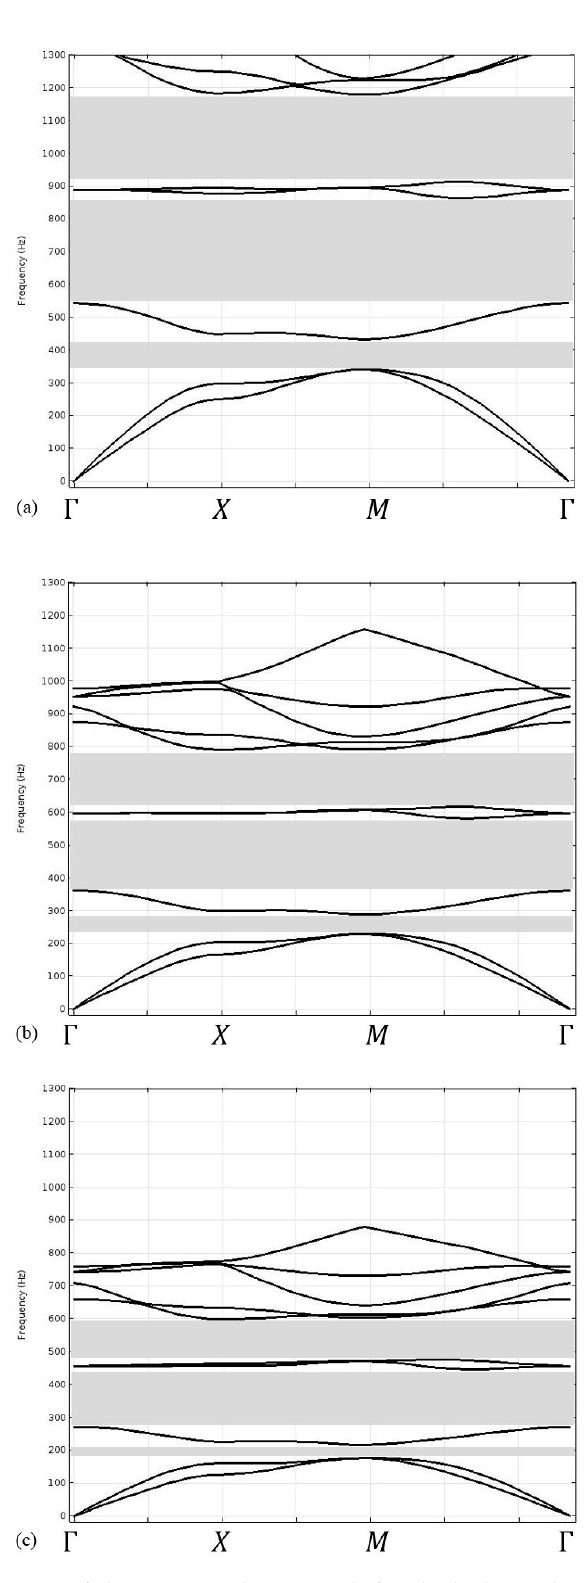
Figure 4. The band structure of phononic crystals composed of steel cylinders and star-shaped honeycombs. ( a ) θ = 55 ◦ , ν = − 0.53 ( b ) θ = 60 ◦ , ν = − 0.35 ( c ) θ = 65 ◦ , ν = − 0.15. Then, the equi-frequency contour (EFC) of the third band of the star-shaped unit cell for the case of θ = 55 ◦ and ν = − 0.53 is plotted in Figure 5. The dashed black line denotes the construction